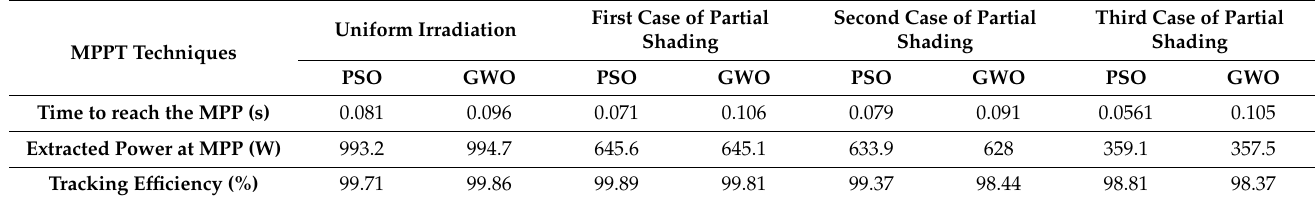
Table 5. Comparative study between PSO-MPPT and GWO-MPPT.